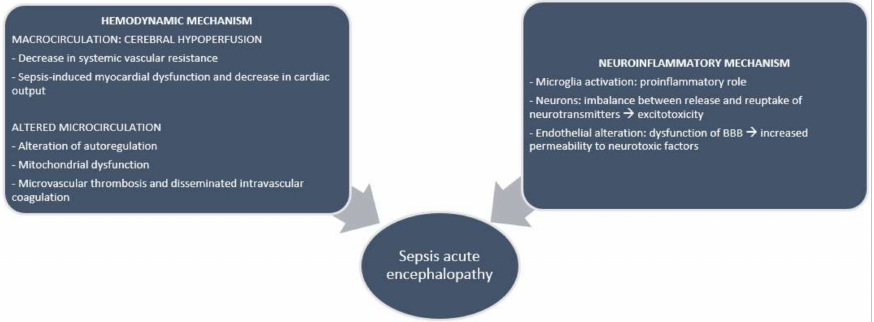
Figure 1. Pathophysiology of sepsis-associated